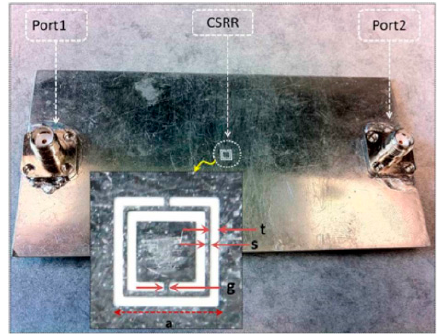
Figure 12. Complementary split-ring resonator (CSRR) printed on the ground plane of a microstrip line (from [38]; copyright © IEEE 2012; reproduced with permission).